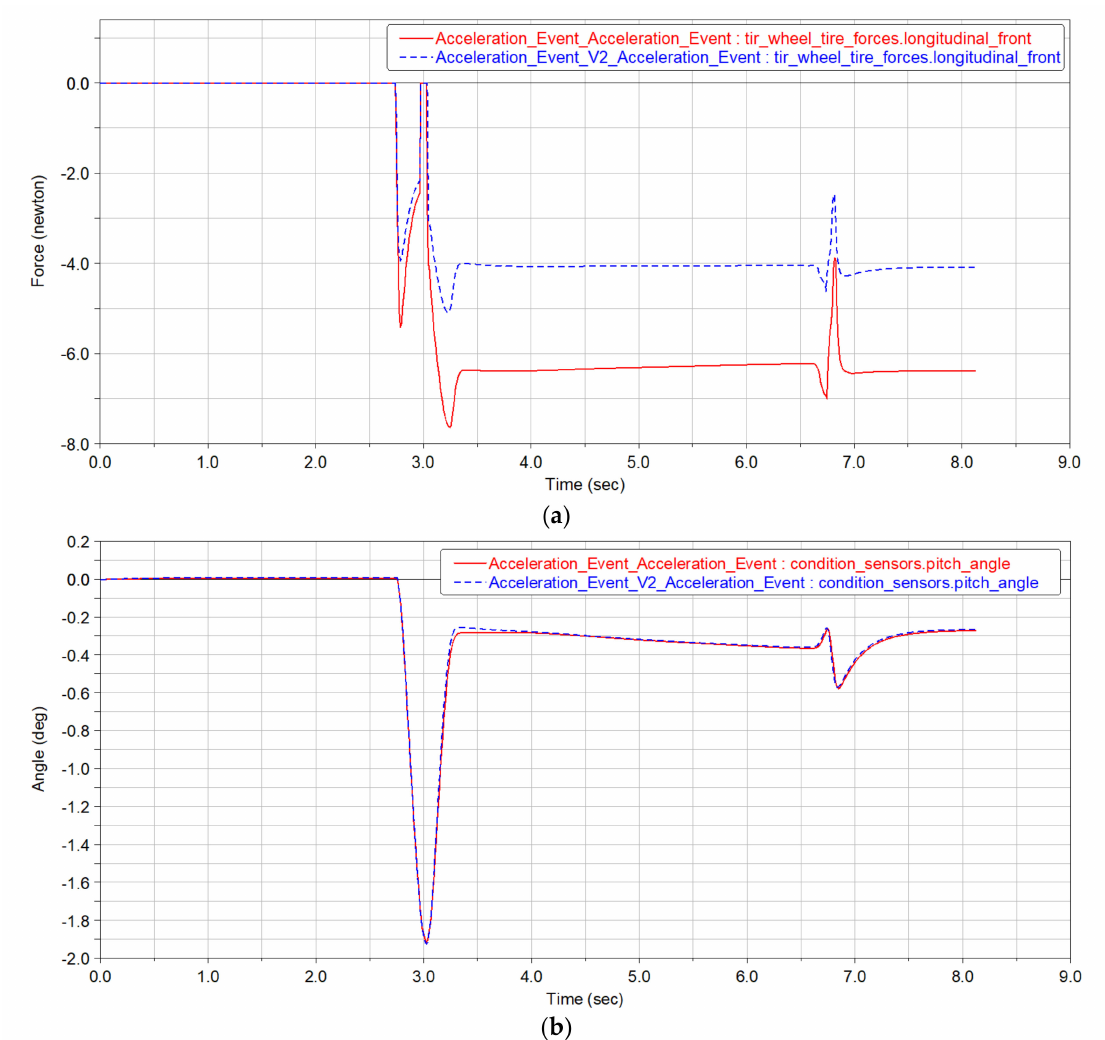
Figure 14. Acceleration Event: ( a ) Front longitudinal force comparison, ( b ) Pitch angle